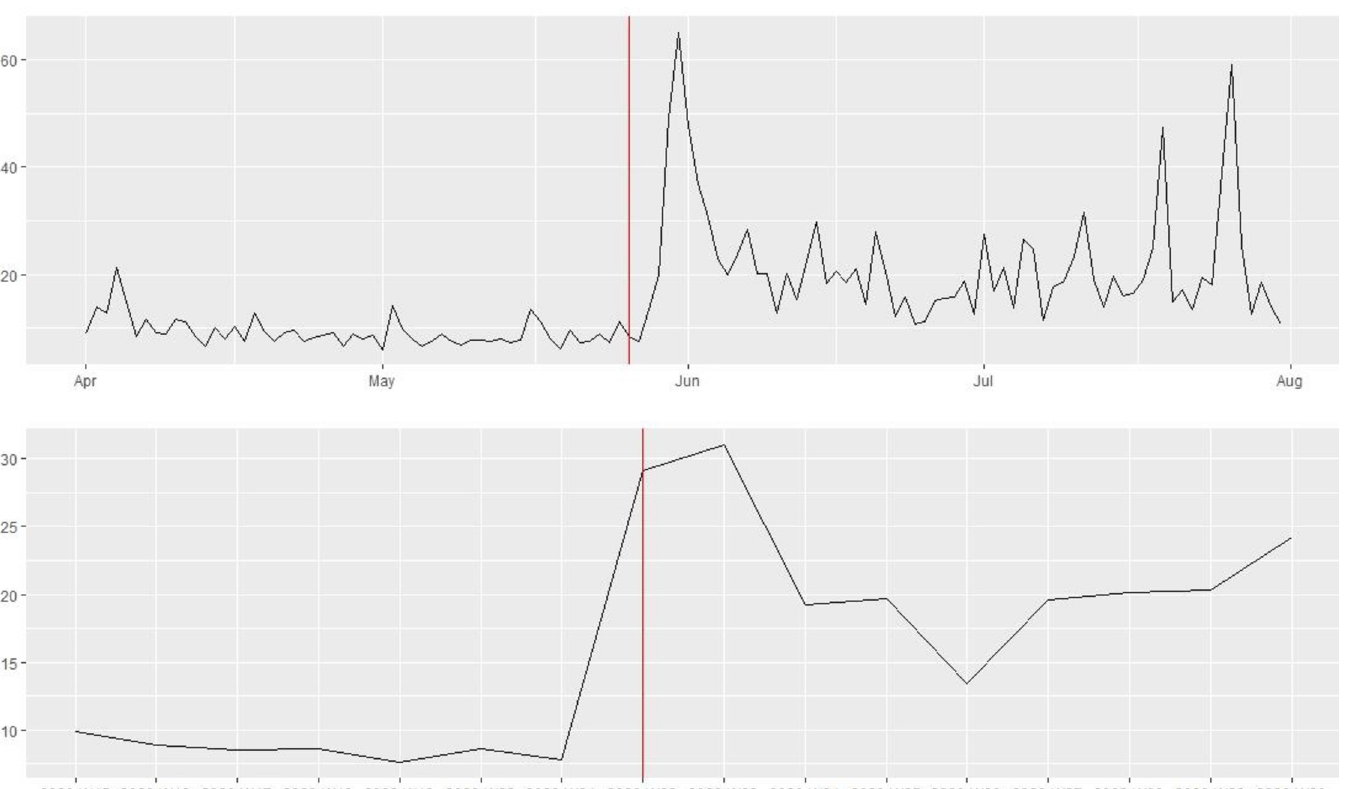
Fig 3. Public reactions (i.e., average number of retweets per tweet) to tweets posted by the 115 major police departments in the U.S. before and after the killing of George Floyd on May 25 th , 2020 (above: Daily information; bottom: Weekly information).